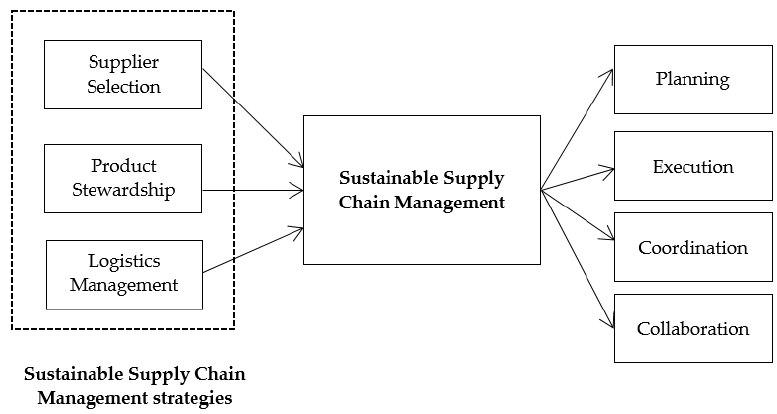
Figure 1. Conceptual research model.